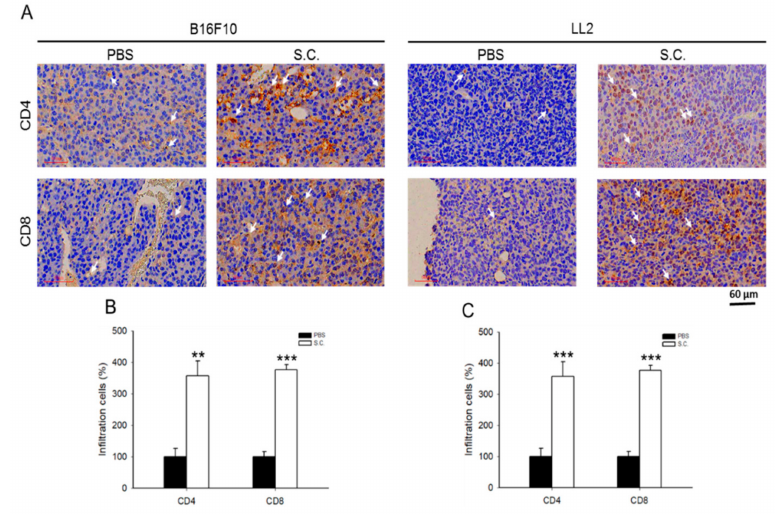
Figure 6. Salmonella (S.C.) enhanced T cells infiltration. Cluster of di ff erentiation (CD) 4 receptors (CD4 + ) and CD8 + infiltrating T cell markers were analyzed by ( A ) immunohistochemical staining and then the number of respective T cells were recorded in each section to determine the percentage of infiltrating T cells from tissues of ( B ) B16F10 and ( C ) LL2 tumor-bearing mice that received either phosphate bu ff ered saline (PBS) or Salmonella treatment ( × 200; Scale bar = 60 µ m). (Statistical significance was calculated using Student t -test. ** p < 0.01, *** p < 0.001, compared with PBS, n =